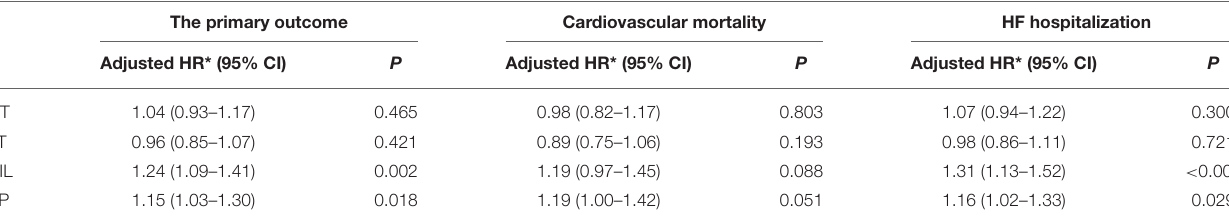
TABLE 5 | Associations of liver function tests and clinical outcomes after excluding patients with liver function test > 2 times upper limit of